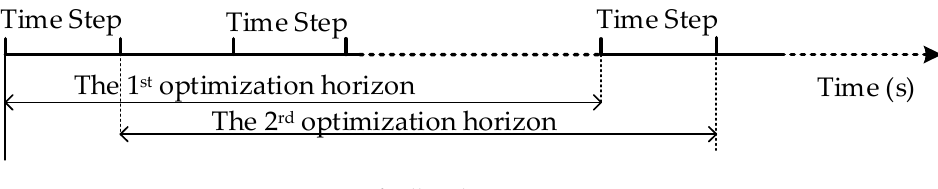
Figure 3. Diagram of rolling horizon optimization strategy.